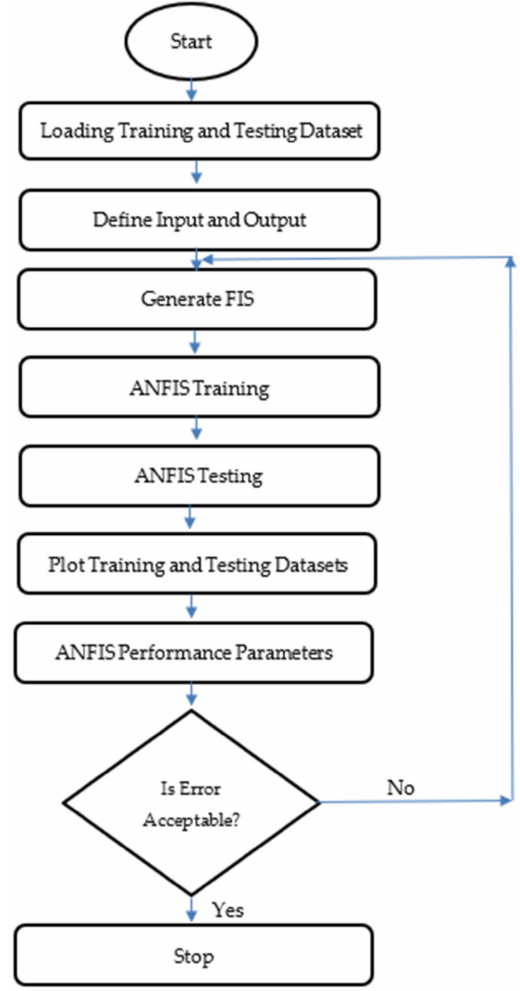
Figure 4. Flow chart of